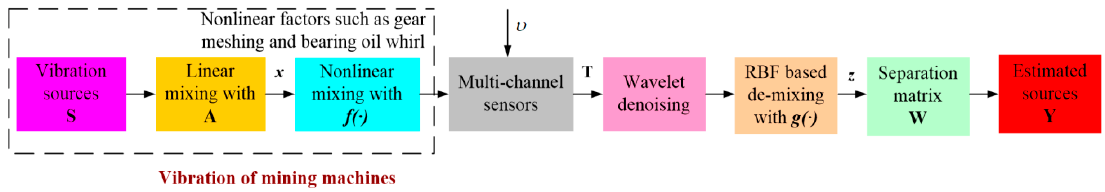
Figure 2. Nonlinear blind separation of vibration signals of mining machines with additive noise.